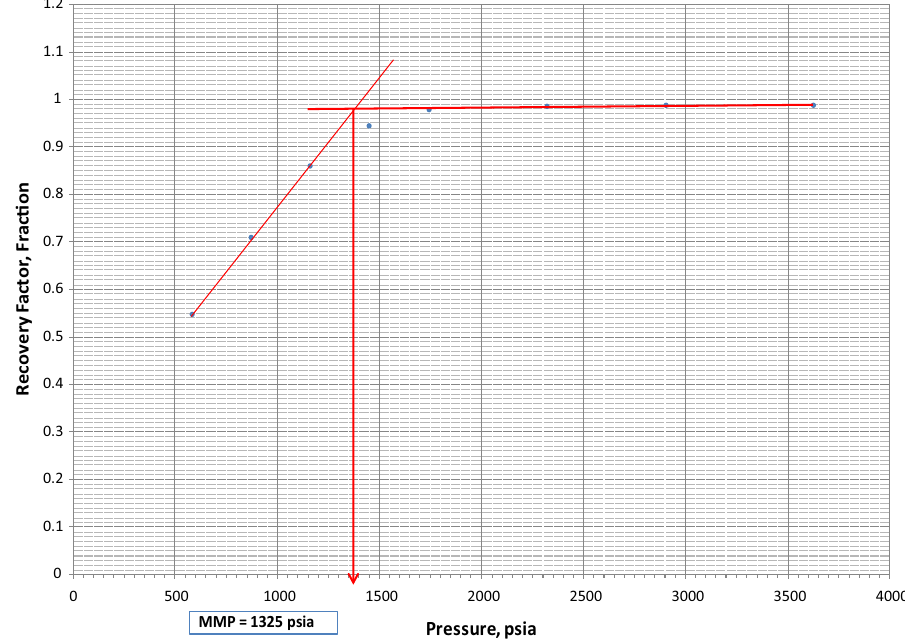
Fig. 3 Estimation of MMP at 246 °F reservoir temperature